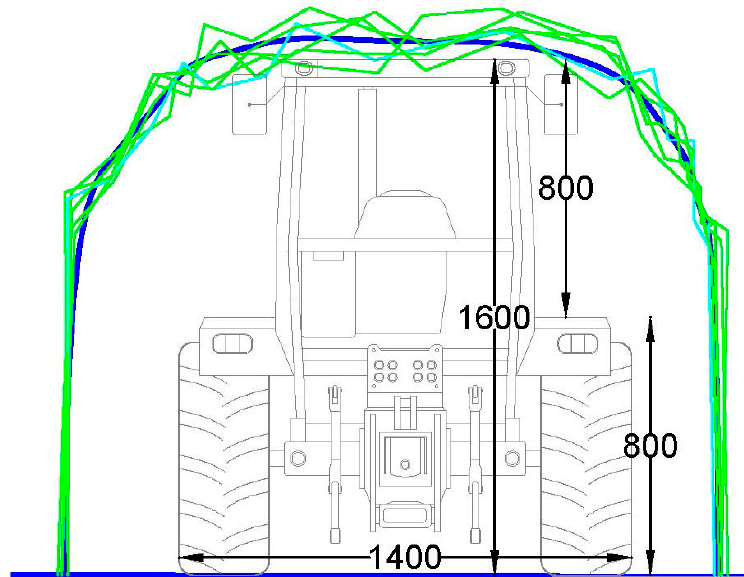
Figure 5. Tendone vineyard (located in Rutigliano, Bari Province, Southern Italy). Set of splines (green lines), characteristic contour (blue line) of the vineyard canopy and hypothetical size of the compact tractor (sizes in mm).